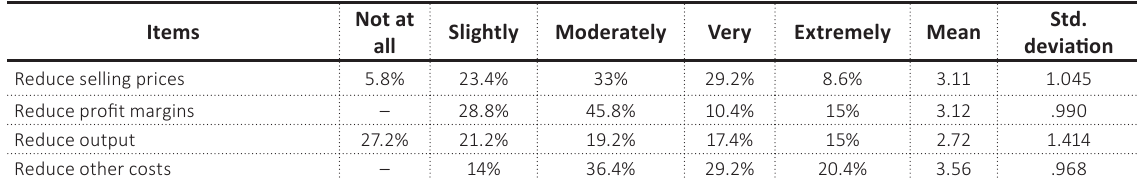
Table 6. Firms’ reaction to an unanticipated slowdown in demand